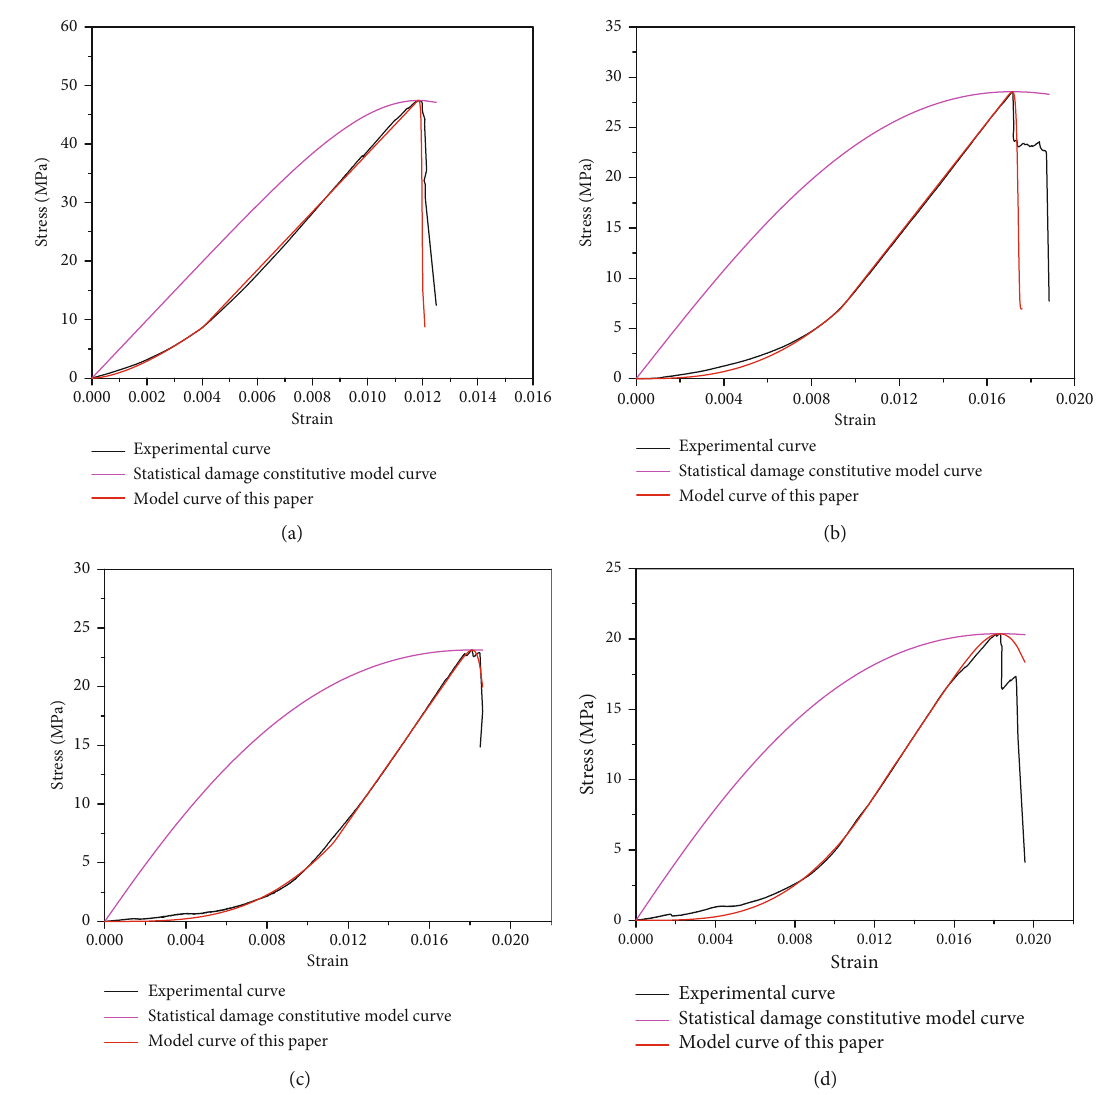
Figure 14: Comparison of experimental and theoretical curves. (a) W0-1, (b) W1-1, (c) W2-1, and (d)